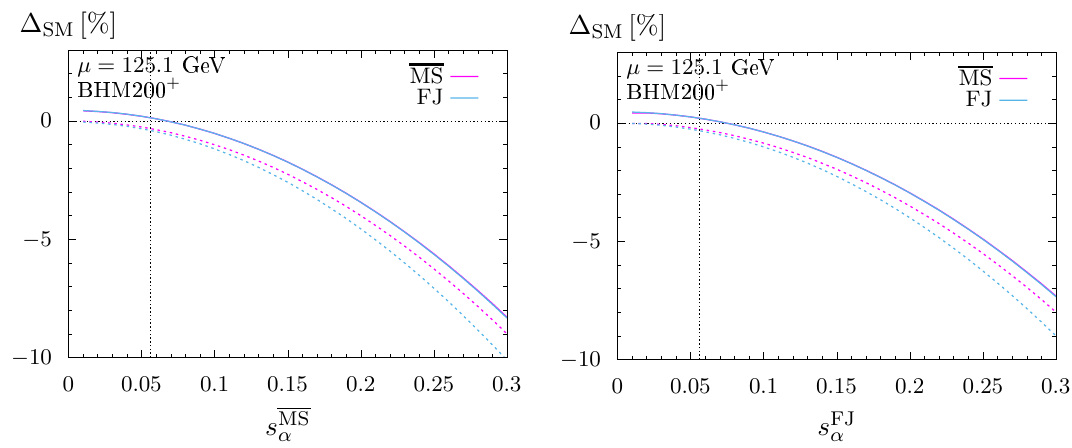
Figure 14 . Deviation of the LO and NLO decay widths (cid:0) h ! 4 f in the SESM from the SM values, as a function of s (cid:11) . Free parameters other than s (cid:11) are (cid:12)xed according to benchmark scenario BHM200 + (see table 2). The vertical dashed line signals that for s (cid:11) . 0 : 06 perturbativity problems might